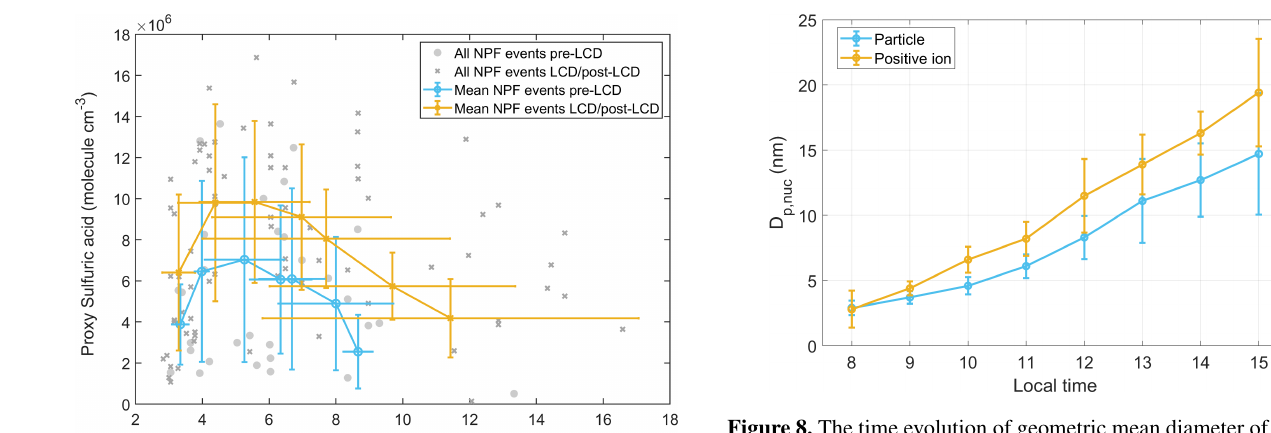
Figure 8. The time evolution of geometric mean diameter of nucle- ation mode ( D p , nuc ) of neutral particle and positive charged ions during the NPF events. The circle and bar present the mean value and the standard deviation.